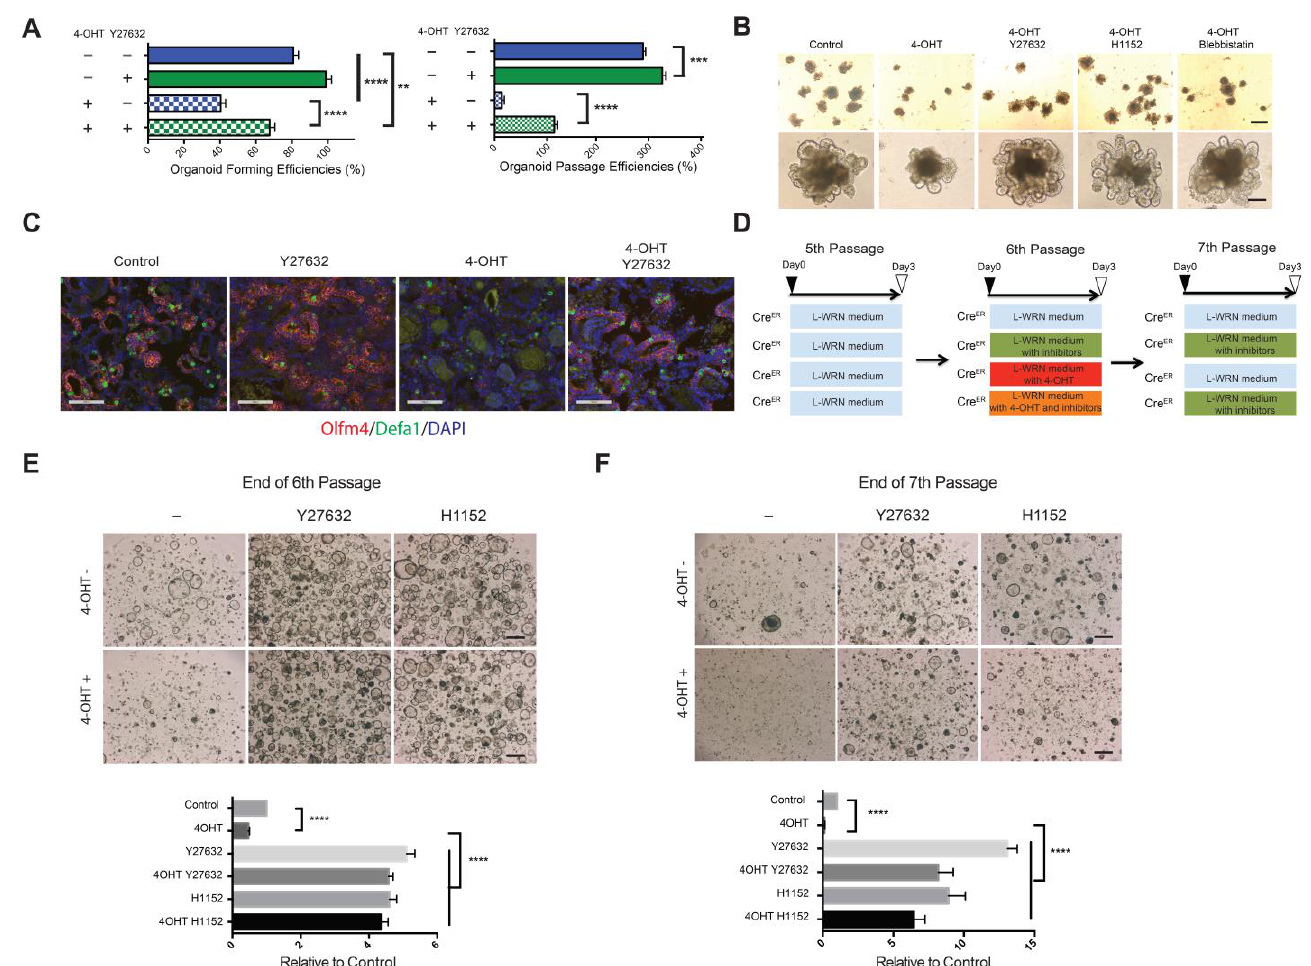
Figure 6. ROCK and myosin II inhibitors attenuate abnormalities in EpCAM KO IEC organoids and spheroids. ( A ) Y27632 significantly improved organoid-forming and passaging efficiencies in KO organoids. Results from 1 of 3 independent experiments (organoid forming) and 1 of 2 independent experiments (organoid passaging) are depicted. ** p < 0.01, *** p < 0.001 and **** p < 0.0001 via Student’s t test. ( B ) Phase contrast photomicrographs of IEC organoids with and without treatment with 4-OHT (for the initial 3 d) and pharmacologic inhibitors (for the entire 9 d) of the culture period as indicated. Y27632 (10 µ M), H1152 (0.31 µ M) and blebbistatin (10 µ M) were tested. Bars = 250 µ M (upper panels), 100 µ M (lower panels). ( C ) Detection of stem cells ((Olfm4 + , red); Paneth cells (Defa1 + , green)) using FISH and control or EpCAM KO organoids in the presence and absence of Y27632 at Day 9 as indicated. DAPI (blue). Bars = 100 µ M. Data from 1 of 2 independent experiments are shown. ( D ) Strategy for drug treatment and passaging of IEC spheroids. Sixth passage spheroids were treated with 4-OHT in the presence and absence of Y27632 or H1152 for 3 d as indicated. ROCK inhibitors were also added to the media used to propagate 7th passage spheroids as indicated. ( E , F ) Phase contrast photomicrographs and numbers of control and EpCAM KO ROCK inhibitor-treated spheroids on Day 3 of the 6th passage ( E ) or Day 3 of the 7th passage ( F ). Bars = 500 µ M. **** p < 0.0001 via Student’s t test. Data depicted represent mean ± SEM in ( A , E , F ). Images from 1